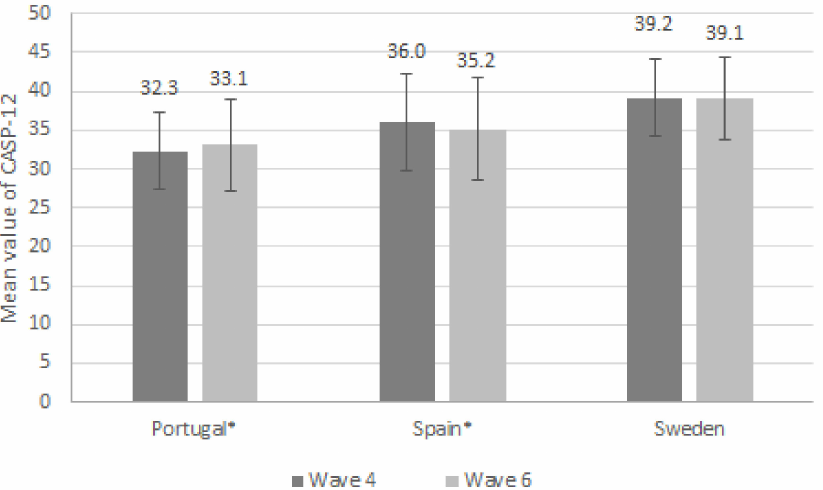
Figure 1. Means and standard QoL deviations (CASP-12) by country and wave. T-test for paired data ( n = 5107). * significant differences at 5% significance